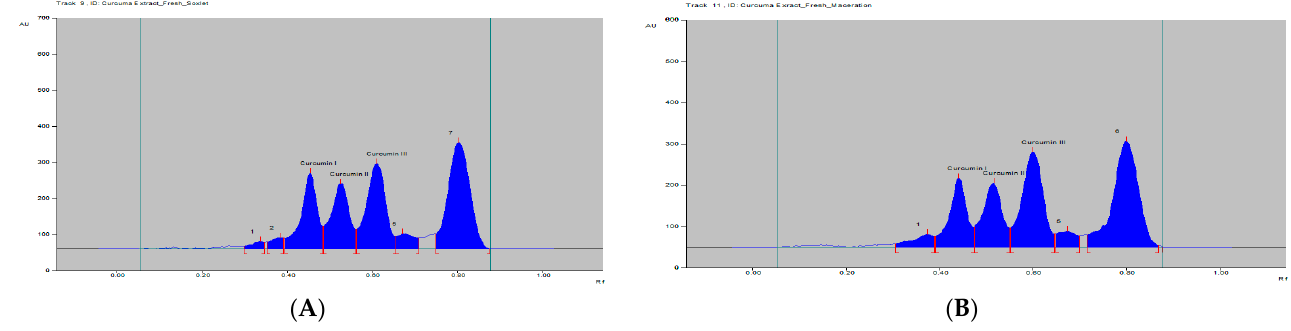
Figure 3. HPTLC densitogram of fresh C. longa extract by ( A ) soxhlet and ( B ) maceration.